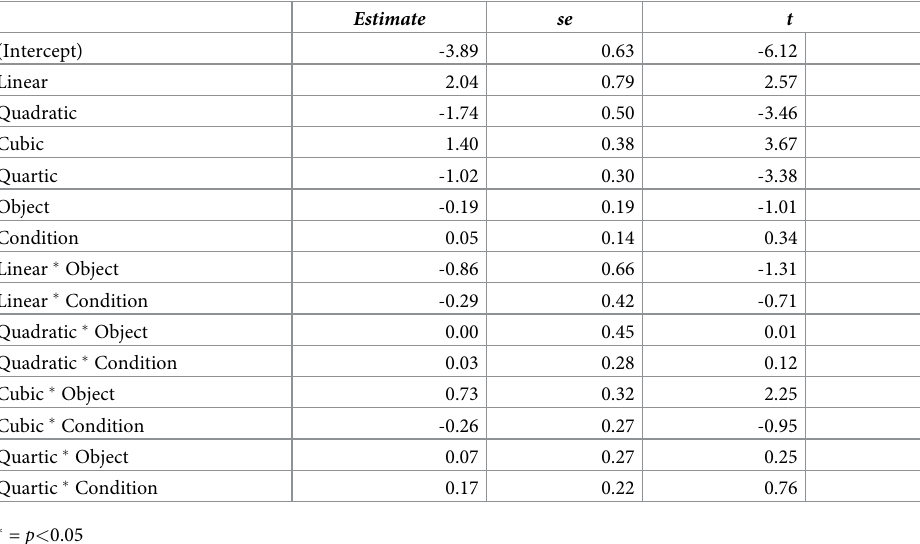
Table 2. Main and interaction effect in the quasi-logistic GCA mixed model analysis.